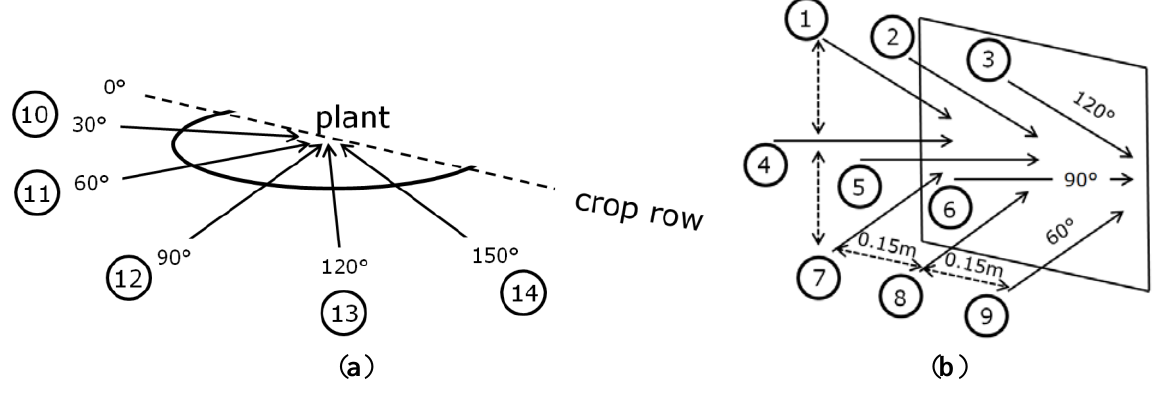
Figure 3. ( a ) Label numbers for the different azimuth positions from which images were